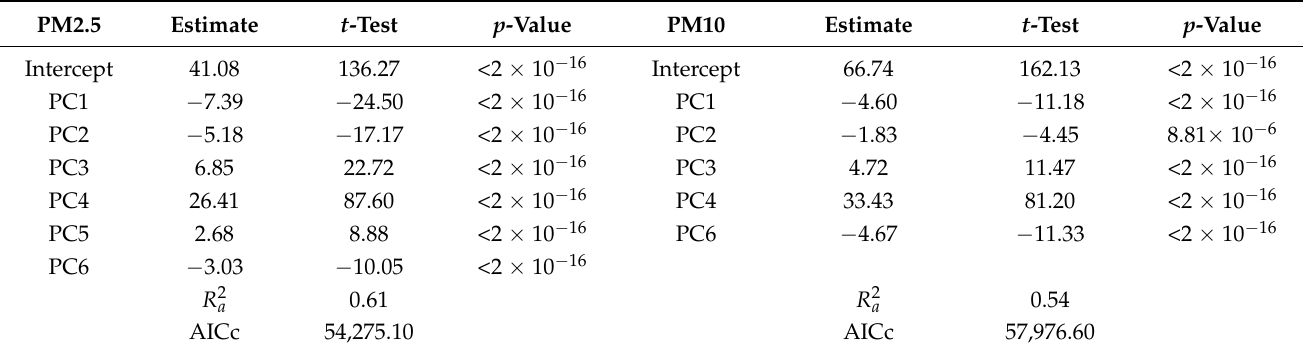
Table 3. PCA-OLS model’s parameter estimations for PM ( p < 0.01). PM2.5